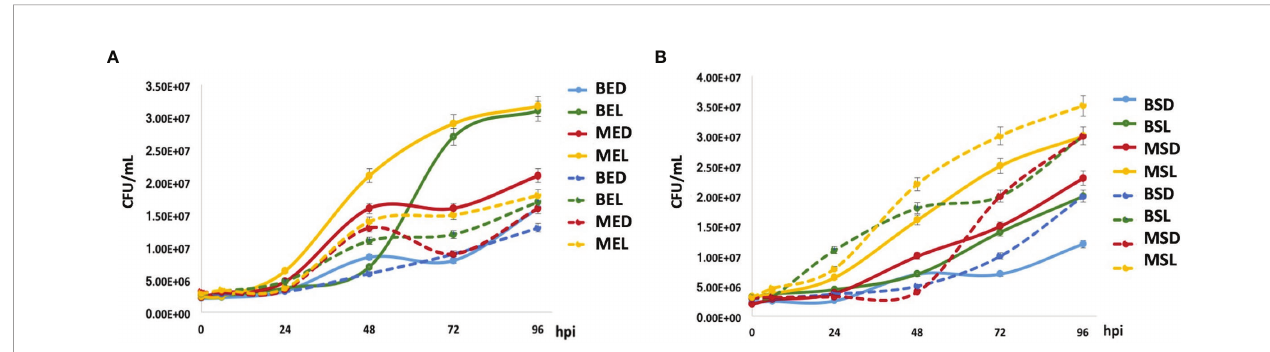
FIGURE 7 | M. bovis BCG intracellular growth inside THP-1 macrophages. Mycobacterial multiplication rates were evaluated every 24 h in a 96-h mycobacteria – macrophage interaction kinetic. THP-1 macrophages (5 × 10 5 ) were infected with wtBCG or mtBCG strains using a MOI of 5:1. CFUs/mL were calculated (continues lines) and compared with those obtained with each microorganism culture in RPMI medium without macrophages (dotted lines). All experiments were performed in triplicate using wtBCG or mtBCG cultured in dextrose or lipids during the exponential phase (A) (BED, wtBCG dextrose; BEL, wtBCG lipids; MED, mtBCG dextrose; MEL, mtBCG lipids), or the stationary phase (B) (BSD, wtBCG dextrose; BSL, wtBCG lipids; MSD, mtBCG dextrose; MSL, mtBCG